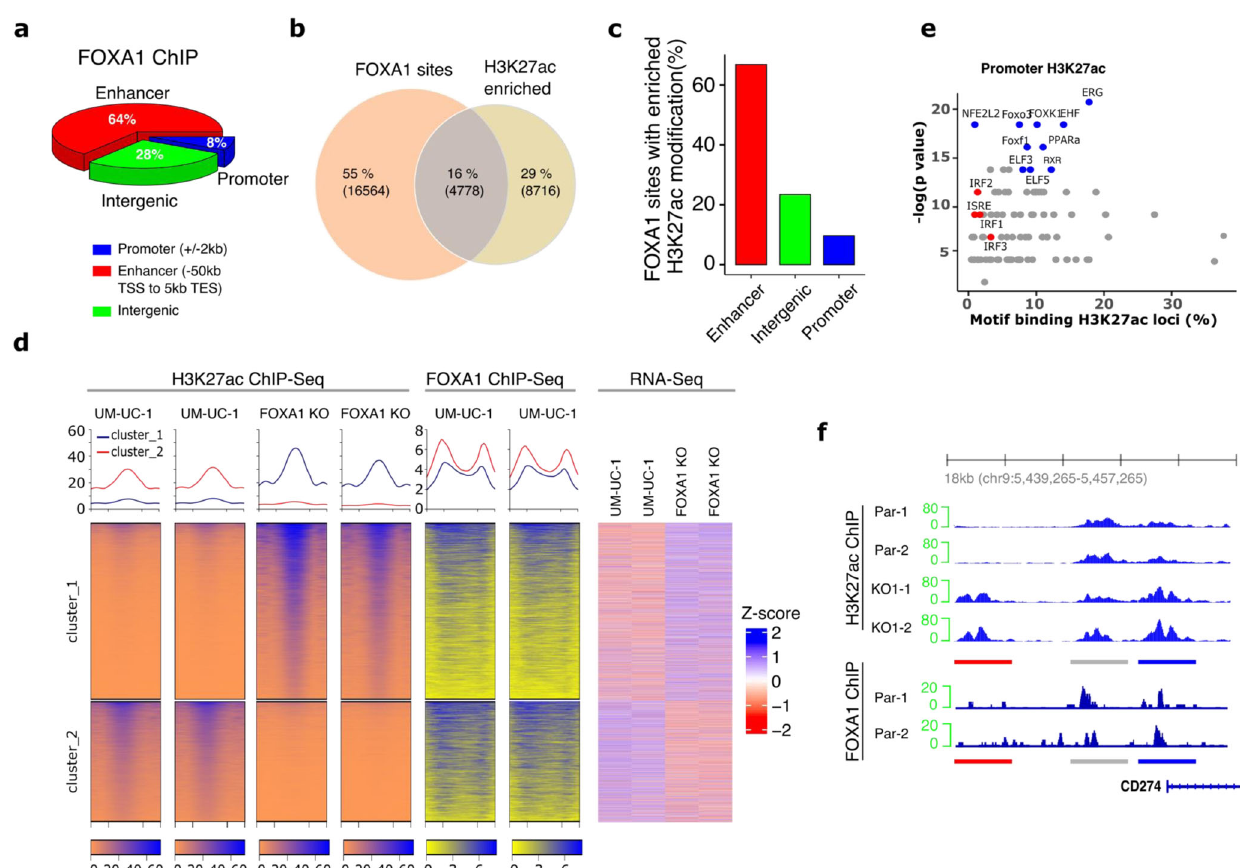
Fig. 6 | FOXA1 knockout was associated with widespread enhancer and pro- moter epigenetic reprogramming in bladder cancer cells. a ChIP-Seq was per- formed in duplicates using chromatin extracted from UM-UC-1 parental and UM- UC-1 FOXA-1-KO cells. 21,766 FOXA1 binding sites were identi fi ed in the ChIP-Seq data by MACS2 (FDR<0.001). Genomic regions where FOXA-1 binding sites were located were then annotated as promoter (2kb+/ − transcriptional start site — TSS), enhancer(between − 50kbfromTSSand5kbaftertranscriptionalendsite — TES),or intergenic (other sites). b Integrated ChIP-Seq analysis of FOXA1 binding sites and H3K27ac revealed 14971 differentially modi fi ed H3K27ac loci enriched in either parental UM-UC-1 cells or those with FOXA1 KO (55% were unique FOXA1 binding, 29% were histone H3K27ac enriched sites, and 16% overlapping sites, de fi ned as within 5kb), c The majority of the overlapping sites were in enhancer regions with fewersitesintheintergenicorpromoterregions. d ClusteranalysisoftheH3K27ac-